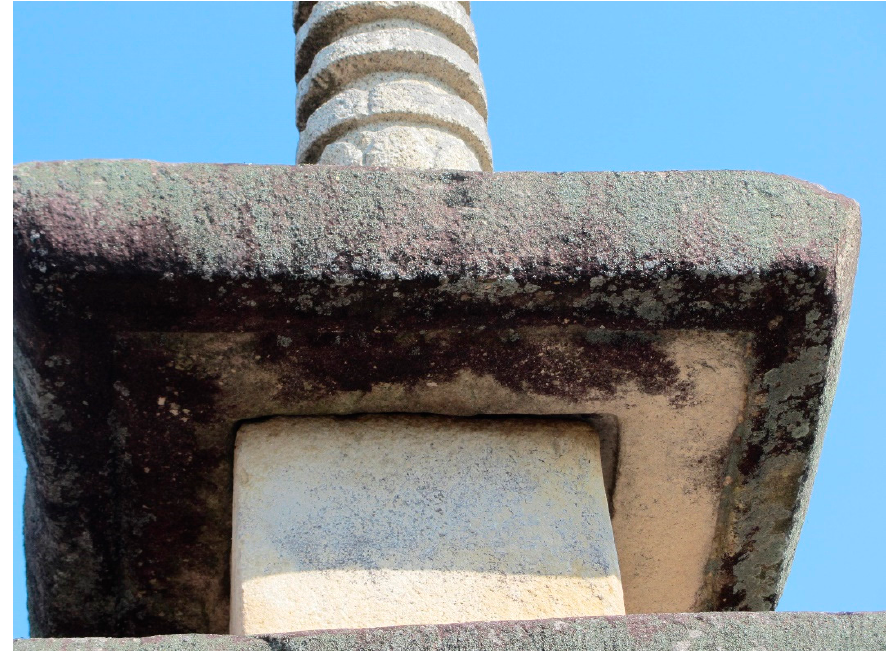
Figure 2. The groove below the eaves at the top story of the Ishid ō ji pagoda.